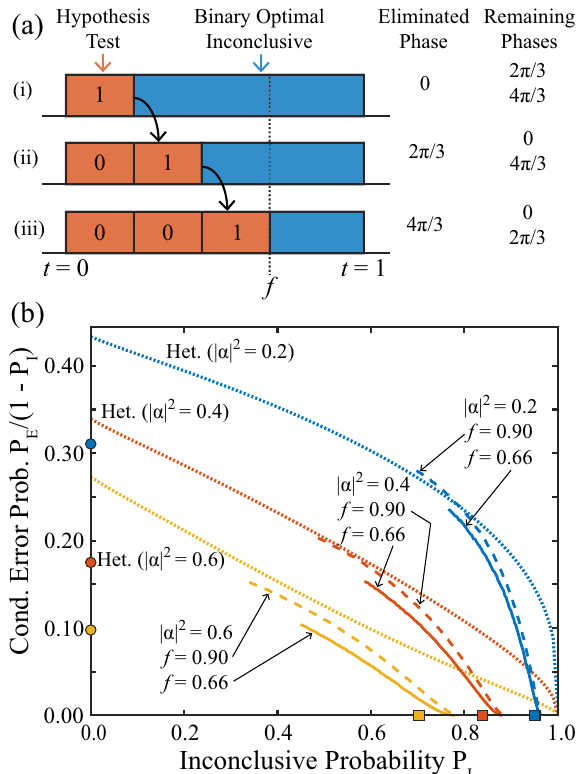
Fig. 3 Inconclusive discrimination of the ternary phase-shift keyed (TPSK) coherent states using the binary optimal incon- clusive measurement. a The proposed inconclusive measurement for TPSK states uses sequential unambiguous state elimination, followed by the optimal binary inconclusive measurement (See main text for details). b Conditional error probability P E /(1 − P I ) as a function of inconclusive probability P I for ∣ α ∣ 2 = 0.2 (blue), 0.4 (orange), and 0.6 (yellow). We compare the proposed measurement with the parameter f = 0.66 (solid) and f = 0.90 (dashed) to the performance of ideal heterodyne detection (dotted). See text for three coherent states with f = 0.66 and f = 0.90, respectively. The = ð 1 (cid:2) P Het dotted lines show the result P Het Þ for using ideal E I